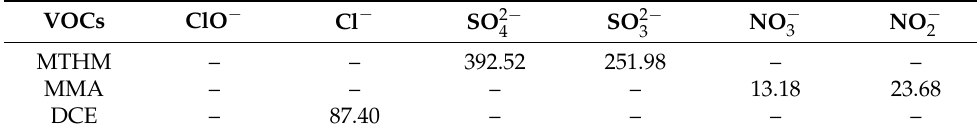
Table 7. IC measurement results of the outlet gas adsorbed by a NaOH